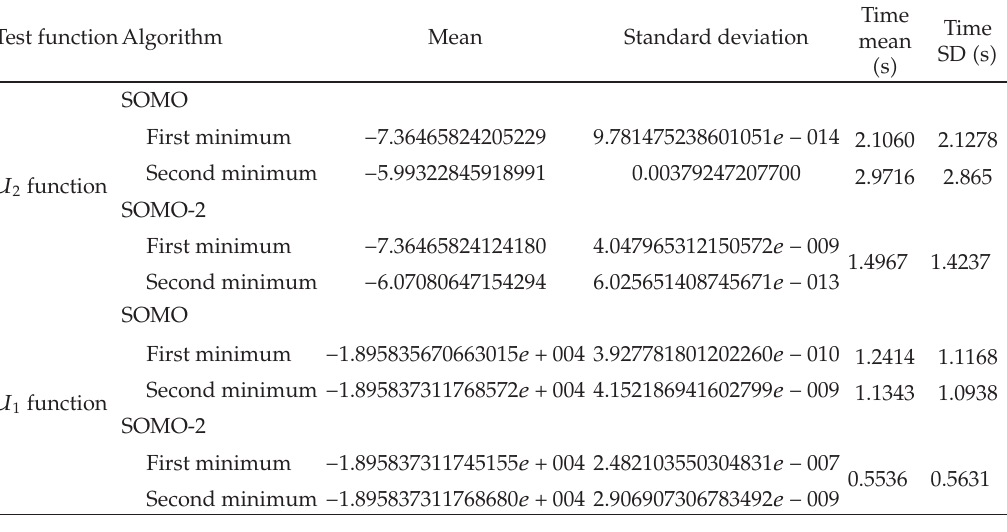
Table 4: Comparison of SOMO-2 and the original SOMO algorithms for finding two minima. Test